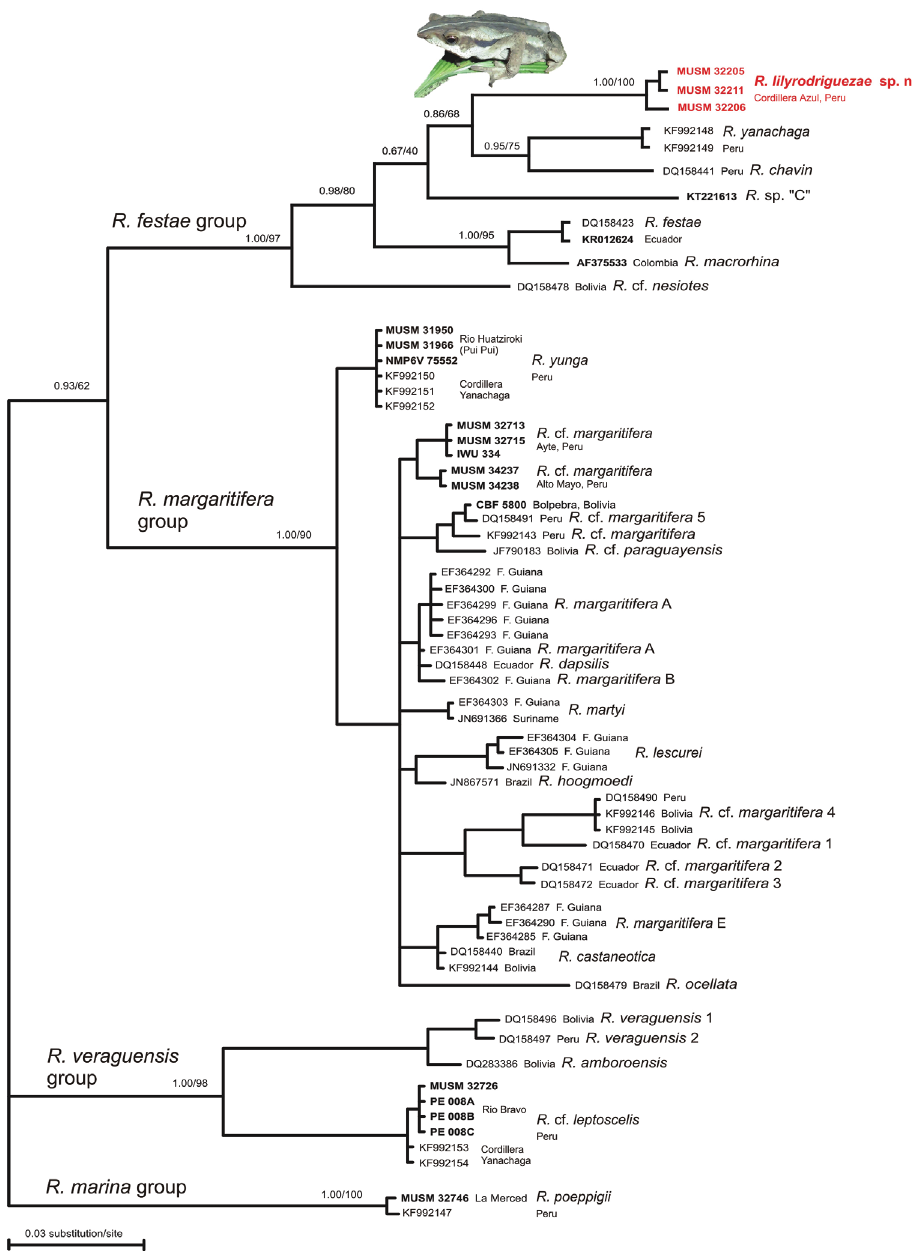
Figure 2. The Bayesian consensus tree resulting from analysis of the mitochondrial 16S rRNA gene data- set for South American Rhinella species based on the data from Moravec et al. (2014) with a special focus on the R. festae group. New samples are in bold. Bayesian posterior probabilities/maximum likelihood bootstrap values for the main clades (species groups) and within the R. festae group are indicated above each node. Three specimens of the new species collected in the Cordillera Azul National Park, Peru, are in